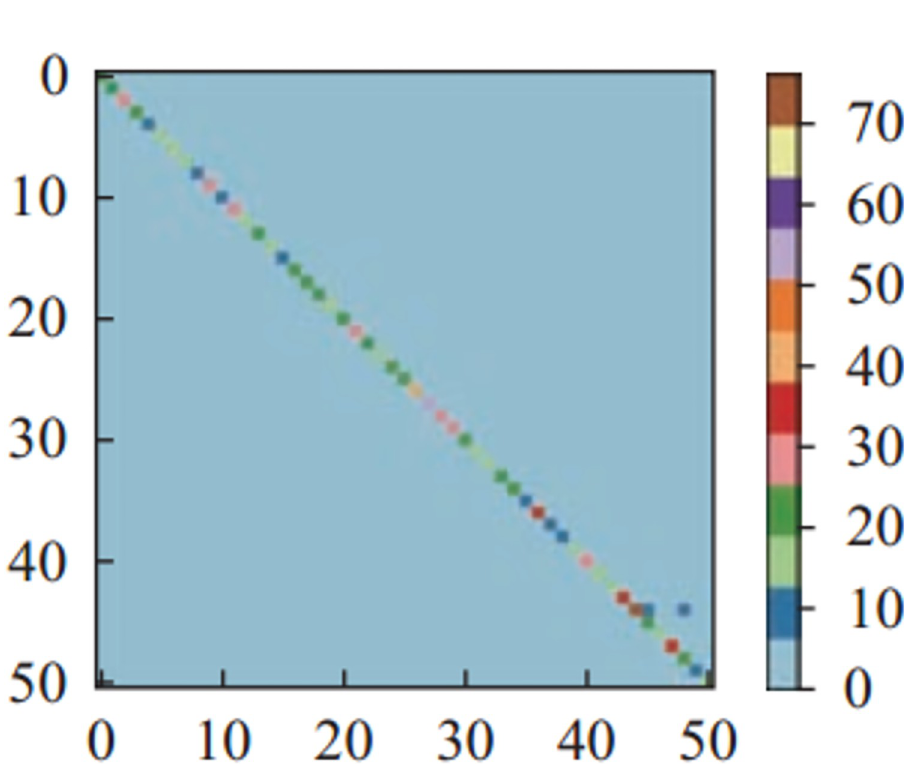
Fig 15. The confusion matrix of the first sectionalization in HMDB-51 under the input cropped & original image.